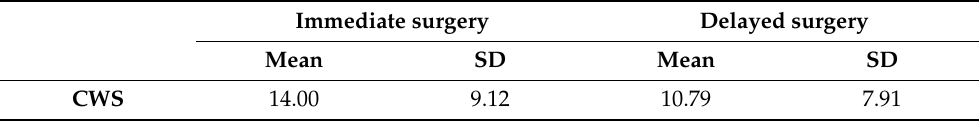
Table 2. CWS score for immediate vs. delayed surgery groups. Mean + SD are given. Score of >14 indicates high fear of recurrence.